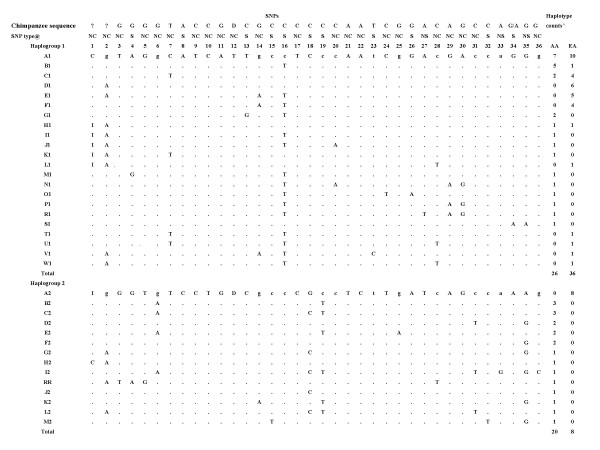
Haplotypes of SDHA. Periods denote the identical SNP variant when compared to the most common haplotype of each haplogroup. @NC = non-coding, S = synonymous coding, NS = non-synonymous coding. I = insertion allele, D = deletion allele. ^AA = African-American samples, EA = European-American samples.